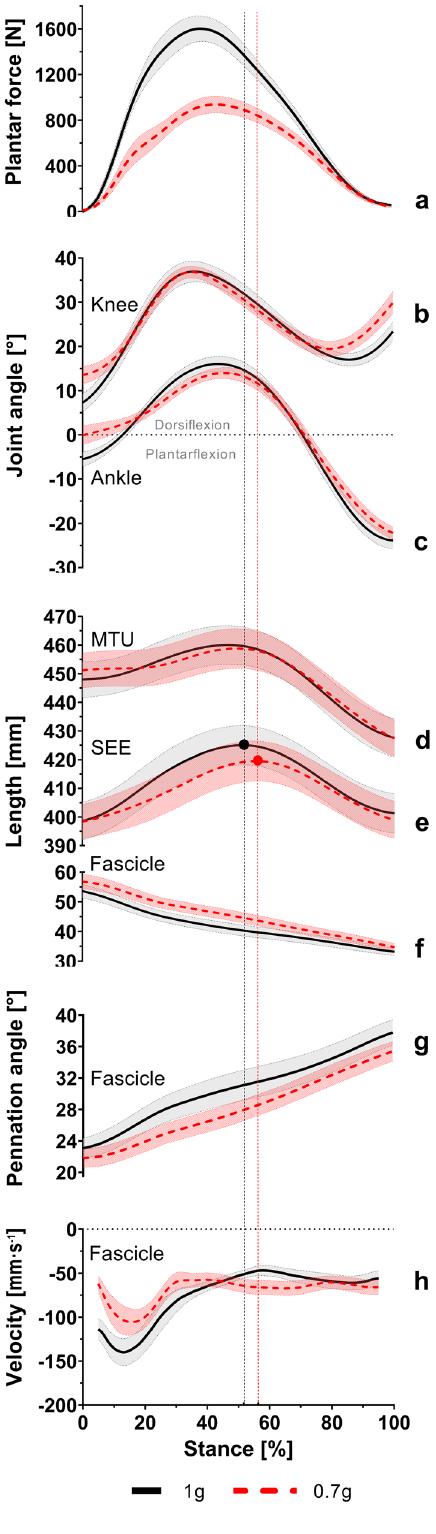
Fig. 1 Kinetic, kinematic, and GM fascicle ‒ SEE parameters during the stance phase of running at 1 g and simulated 0.7 g. Participants ’ average (mean ± standard error of the mean) patterns of plantar forces ( a ), knee ( b ) and ankle ( c ) joint angles, and MTU ( d ) and SEE ( e ) lengths as well as muscle fascicle length ( f ), pennation angle ( g ), and velocity ( h ) change during the stance phase of running at 1 g (black line) and simulated 0.7 g (red dashed line). The vertical lines mark the peak SEE length achieved at 1 g (black) and simulated 0.7 g (red). n = 8